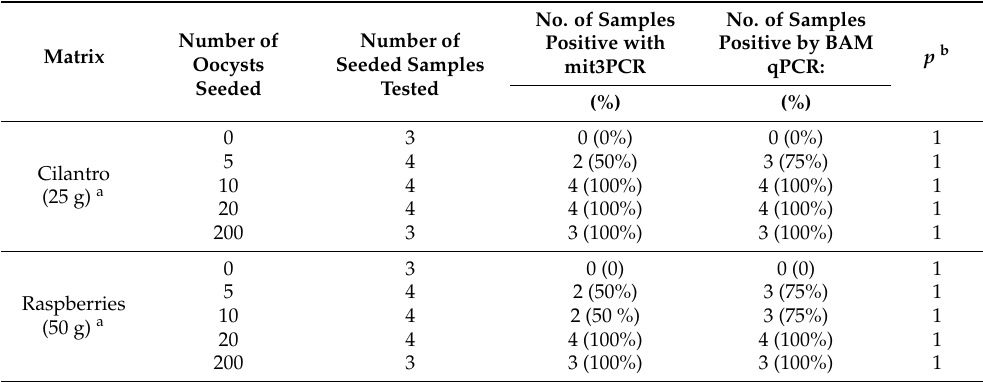
Table 2. Detection rates of C. cayetanensis in food samples by real-time PCR and conventional PCR assays. No. of Samples No. of Samples Number of Number of Positive with Positive by BAM Matrix Oocysts Seeded Samples mit3PCR qPCR: Seeded Tested